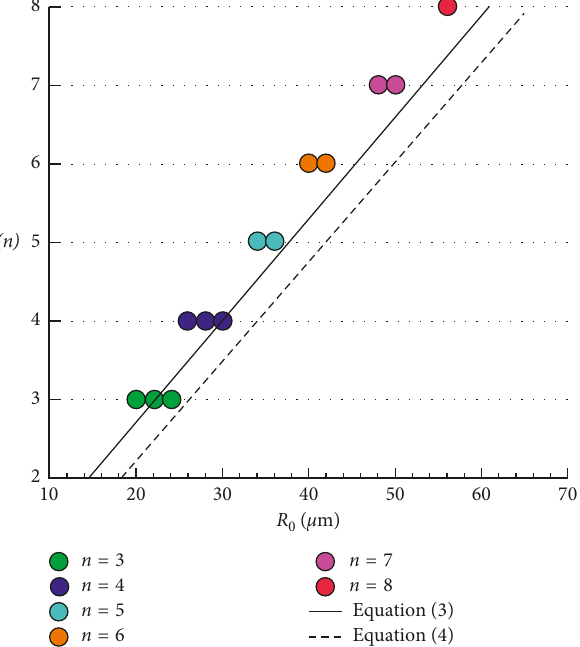
4: The pattern distribution of the bubble shape oscillation mode, when f � 130kHz and P d �